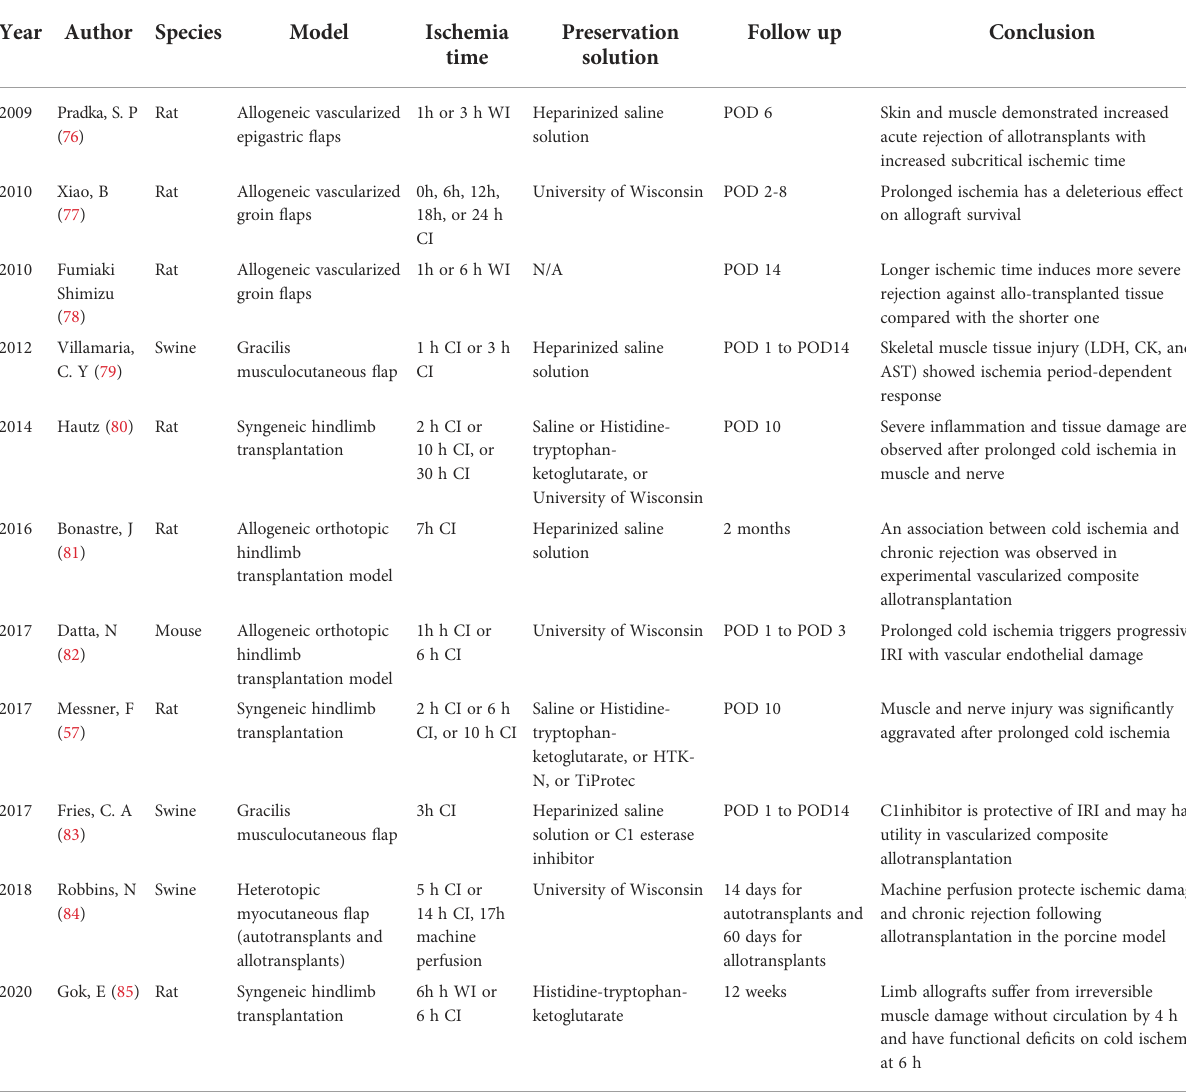
TABLE 2 Relationship between IRI and tissue damage or transplant